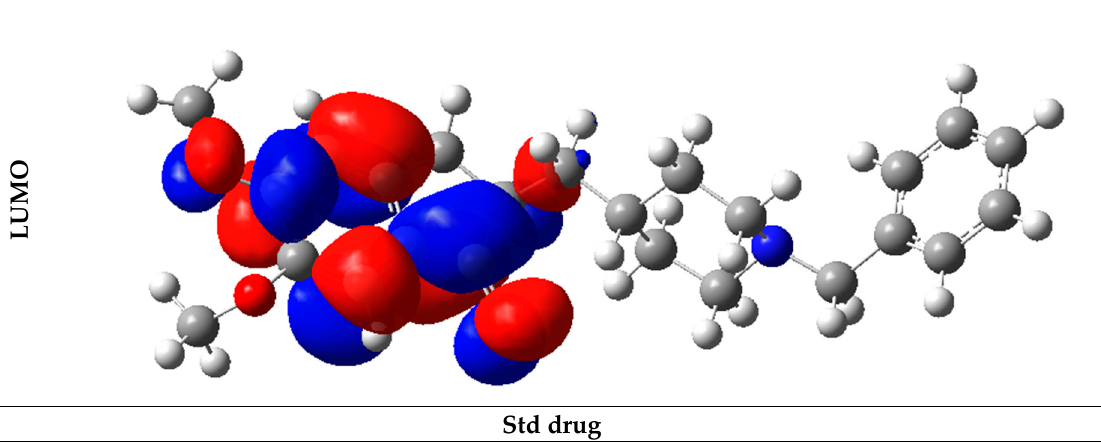
Figure 17. HOMO–LUMO orbital densities of representative thiazole-bearing sulfonamide analogs 1 and 2 and standard drug. Table 3. HOMO, LUMO, and energy gap of studied thiazole-bearing sulfonamide analogs 1 – 21 and standard drug (all values are in eV).